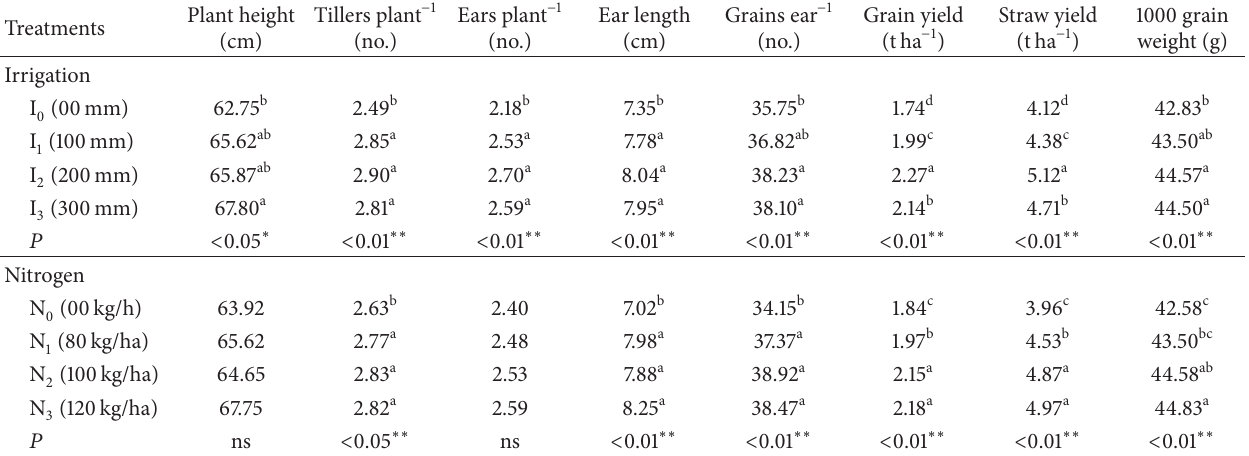
Table 1: Effect of irrigation and nitrogen on the yield and yield contributing characters of wheat. Treatments